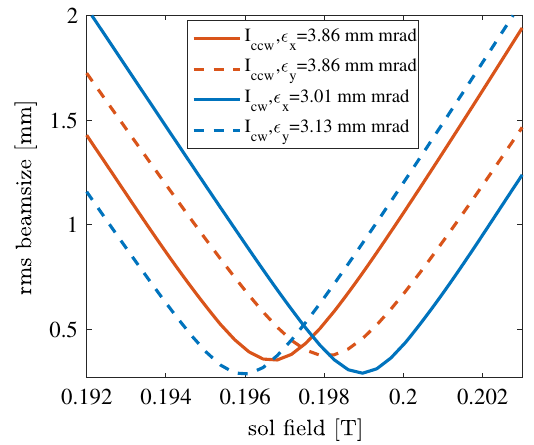
FIG. 10. Solenoid scan simulation fit results. rms beam size as a function of the solenoid field in ASTRA. The solenoid quadru- pole was scanned to fit the simulation to the